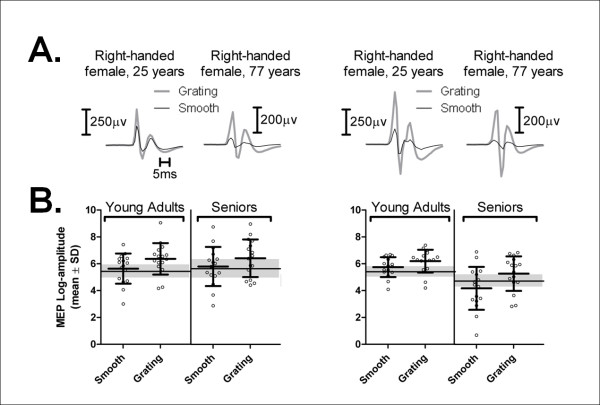
MEP amplitudes during the smooth vs. grating trials in Experiment II. A. Examples of task-related differential modulation in MEP amplitude under the two trial types in the left and right resting hands in typical young (right-handed female, aged 25 years) and older (right-handed female, aged 77 years) participants. Each trace is an average of 12 responses. B. Comparison of mean MEP log-amplitudes in the resting hand when the task hand was performing the two trial types (grating/smooth). The gray area represents the mean and standard error of the baseline resting MEP log-amplitudes in the young adult and senior age groups. Each bar represents the mean of individual values computed for the resting hand when the task hand performed each trial type (grating/smooth) for all young adult (N = 16) and senior participants (N = 16). Note the main effect of trial type in the task hand was significant for the overall variations in MEP log-amplitude in the resting hand (F1,30 = 16.98, p < 0.001, partial eta squared = 0.36), reflecting enhanced MEP amplitudes in the resting hand when the other hand was doing the grating trials vs. the smooth trials (Bonferroni's p = 0.001) or resting baseline values (Bonferroni's p < 0.001), which were not different from one another (Bonferroni's p = 1.0).